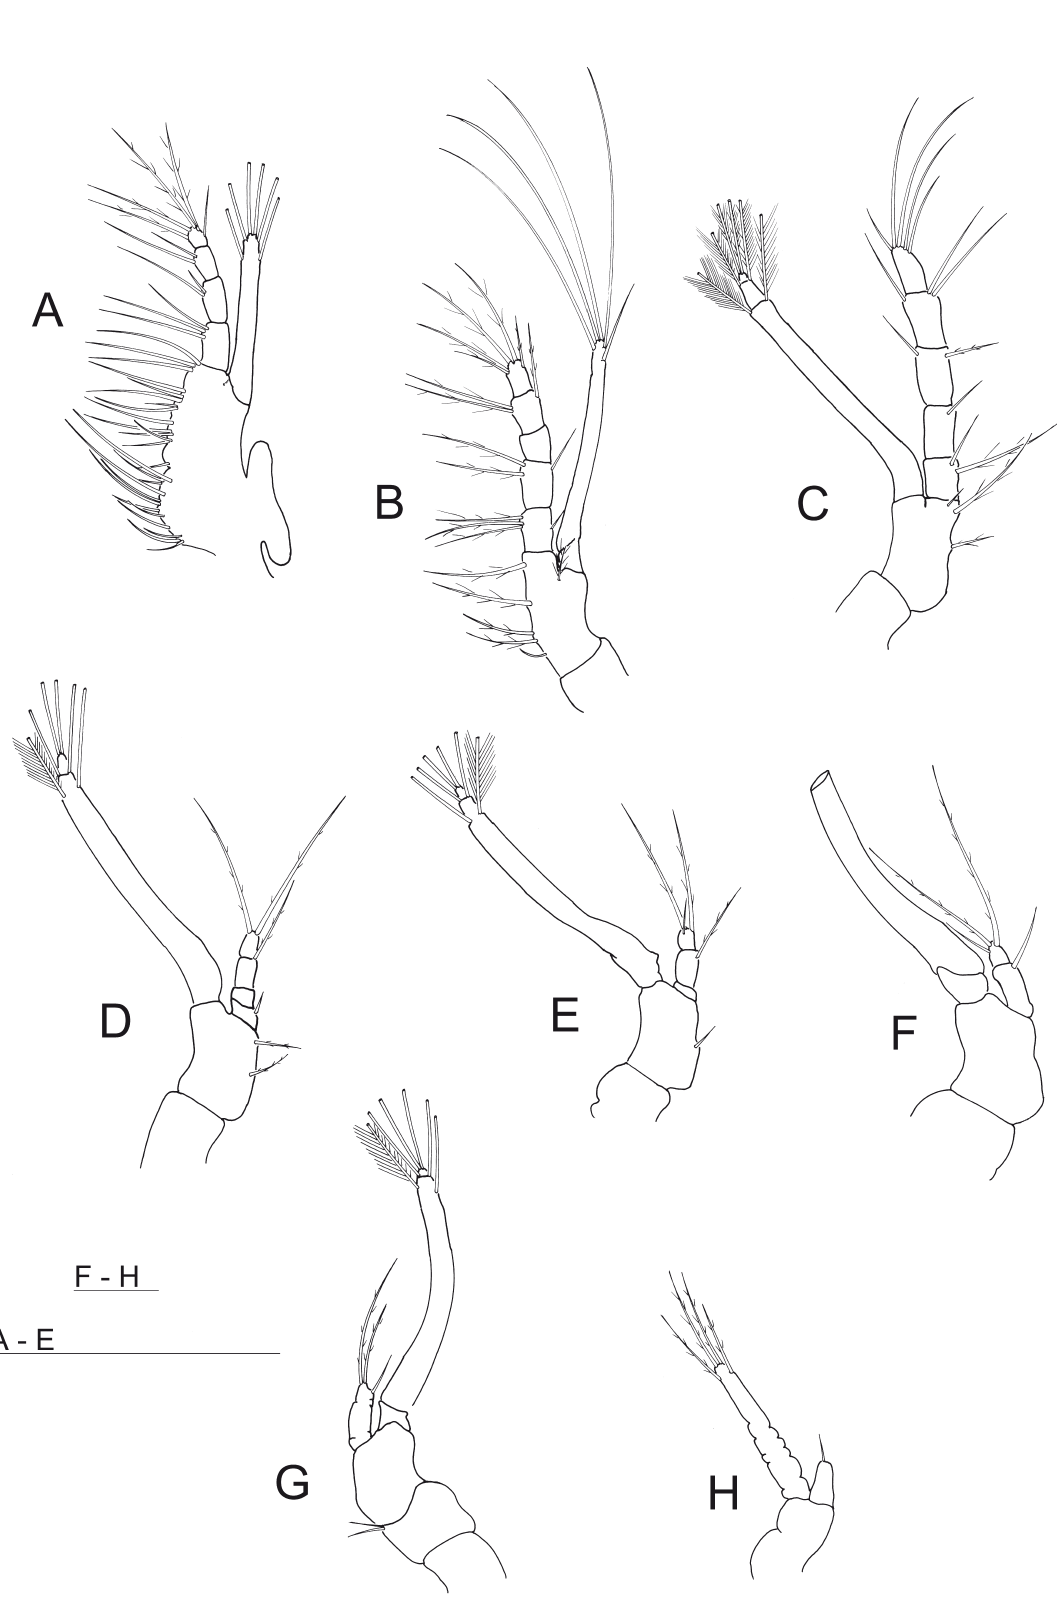
F ig . 3. – Appendages of mysis II of red shrimp Aristeus antennatus (Risso, 1816). A, first maxilliped; B, second maxilliped; C, third maxil- liped; D, first pereiopod; E, second pereiopod; F, third pereiopod; G, fourth pereiopod; H, fifth pereiopod. Scale bars: 1